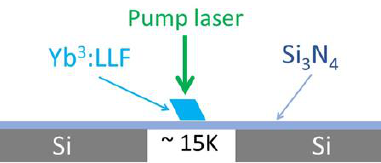
Figure 8. Schematic of 10% Yb 3+ :LLF microcrystals placed on a Si 3 N 4 TEM window.